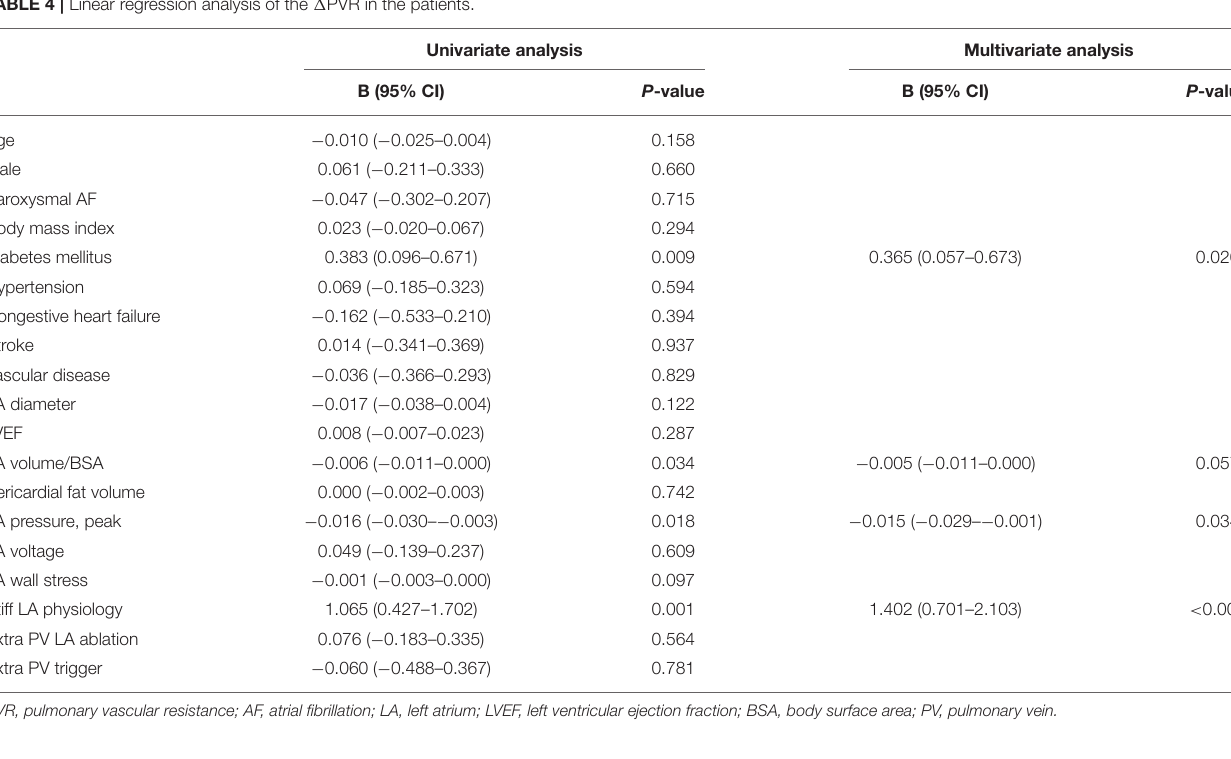
TABLE 4 | Linear regression analysis of the 1 PVR in the patients.